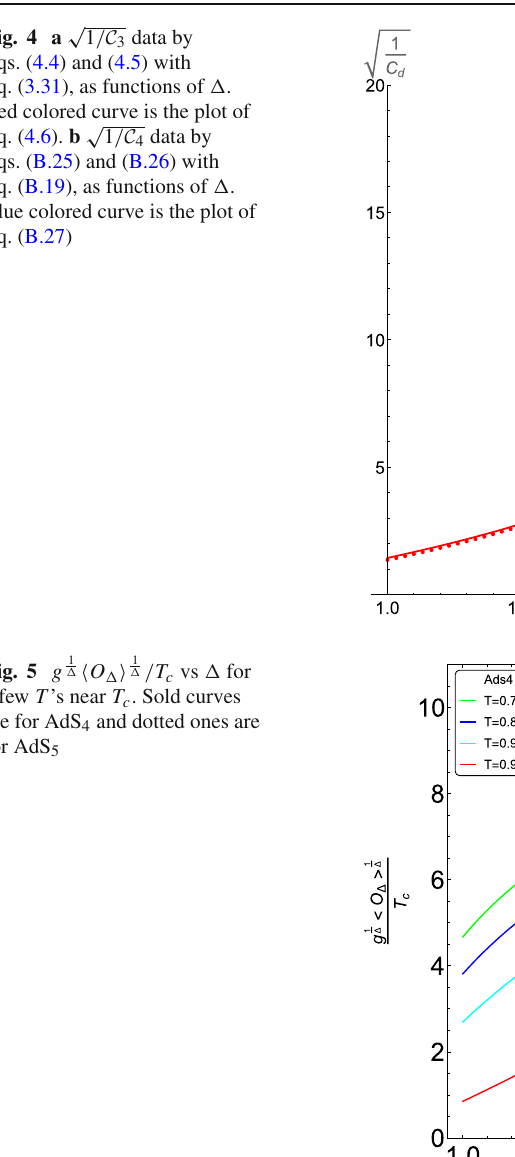
Fig. 5 g 1 (cid:2) (cid:3) O (cid:2) (cid:4) 1 (cid:2) / T c vs (cid:2) for a few T ’s near T c . Sold curves are for AdS 4 and dotted ones are for AdS